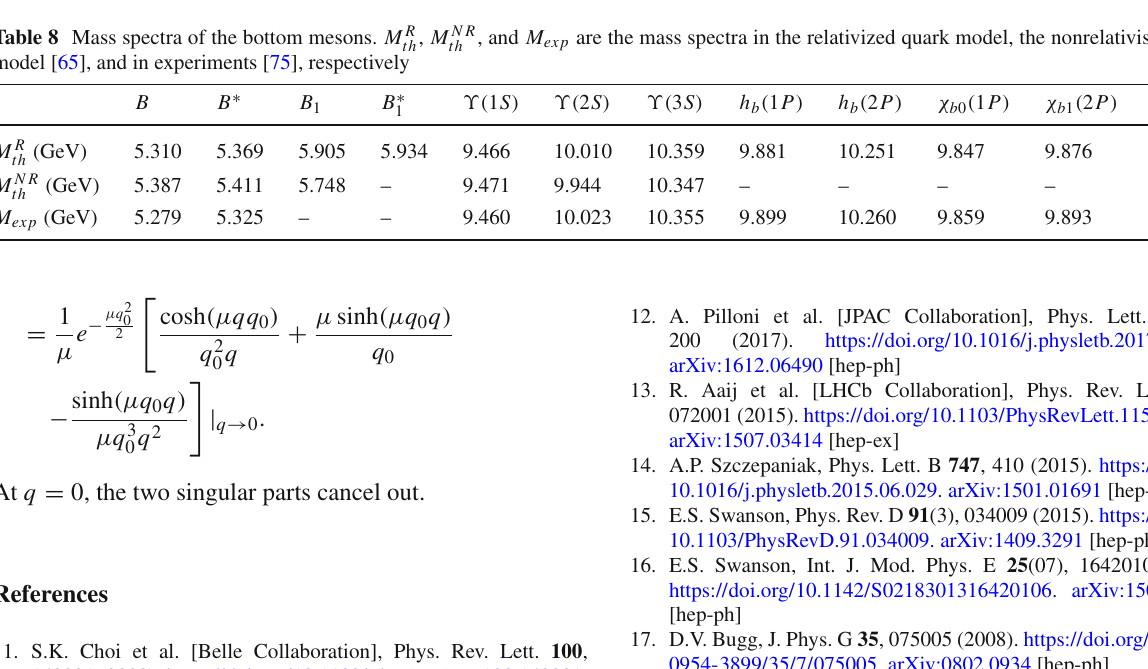
, M NR , and M exp are the mass spectra in the relativized quark model, the nonrelativistic quark th th